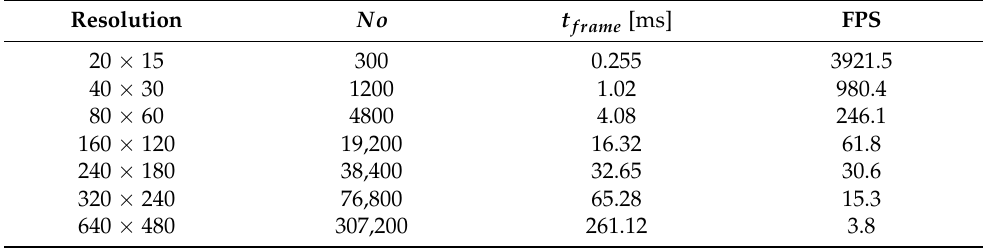
Table 5. Timing (in ms) and Performance (in FPS) of the FPGA part based on the supported